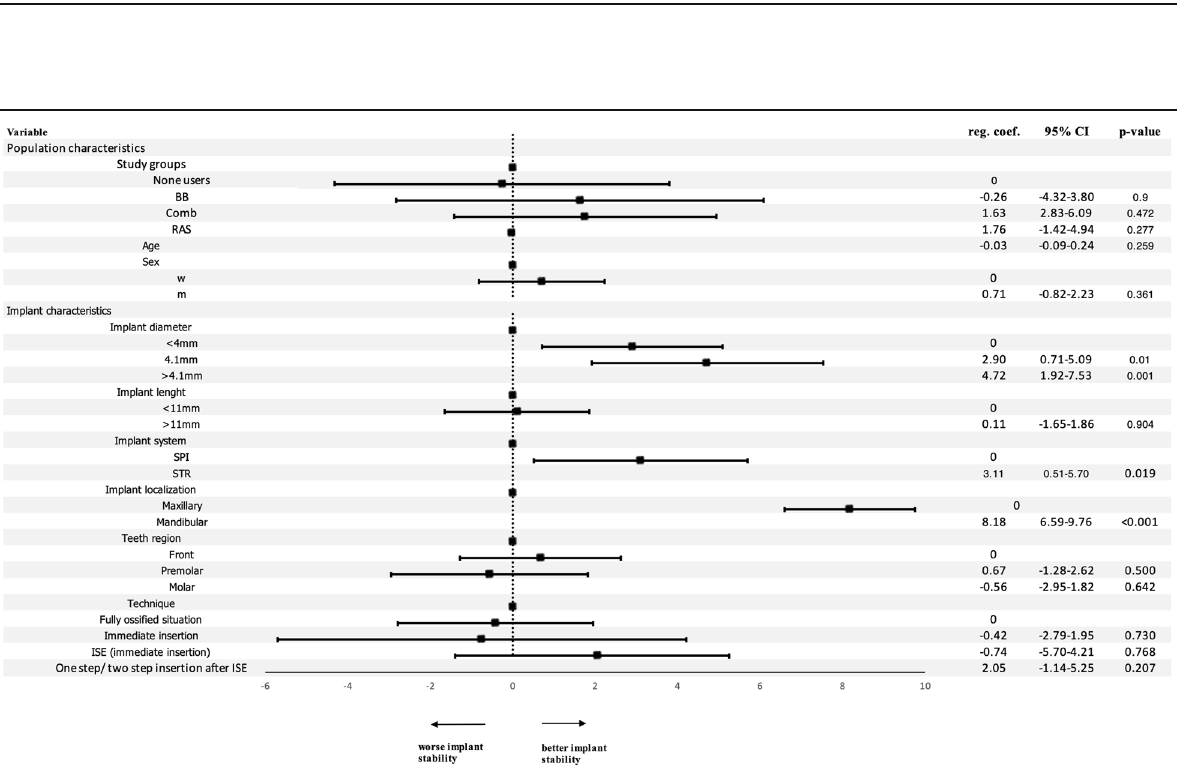
Fig. 2 Distribution of study variables in the study groups via box plots (median and interquartile range) ( a ) and pie charts showing the implant insertion technique ’ s distribution among the study groups ( b ). BB, beta-blocker group; Comb, combined beta-blocker and RAS-inhibitor group; RAS, RAS inhibitor group; ISE, internal sinus elevation; ISQ, implant stability quotient